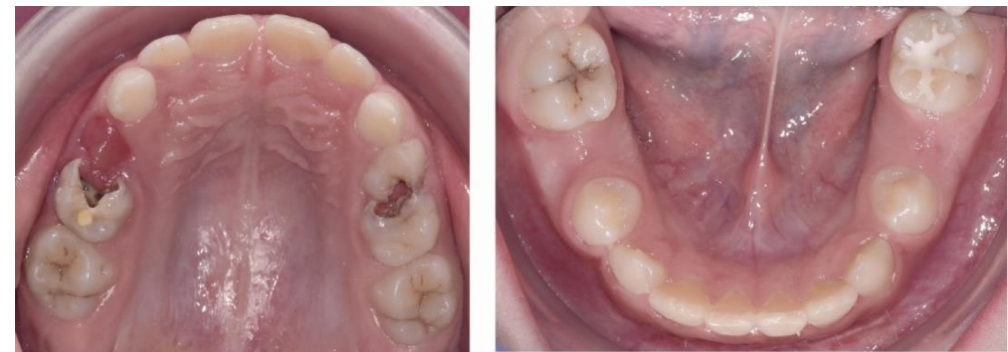
Figure 6. Pre-treatment intra-oral occlusal